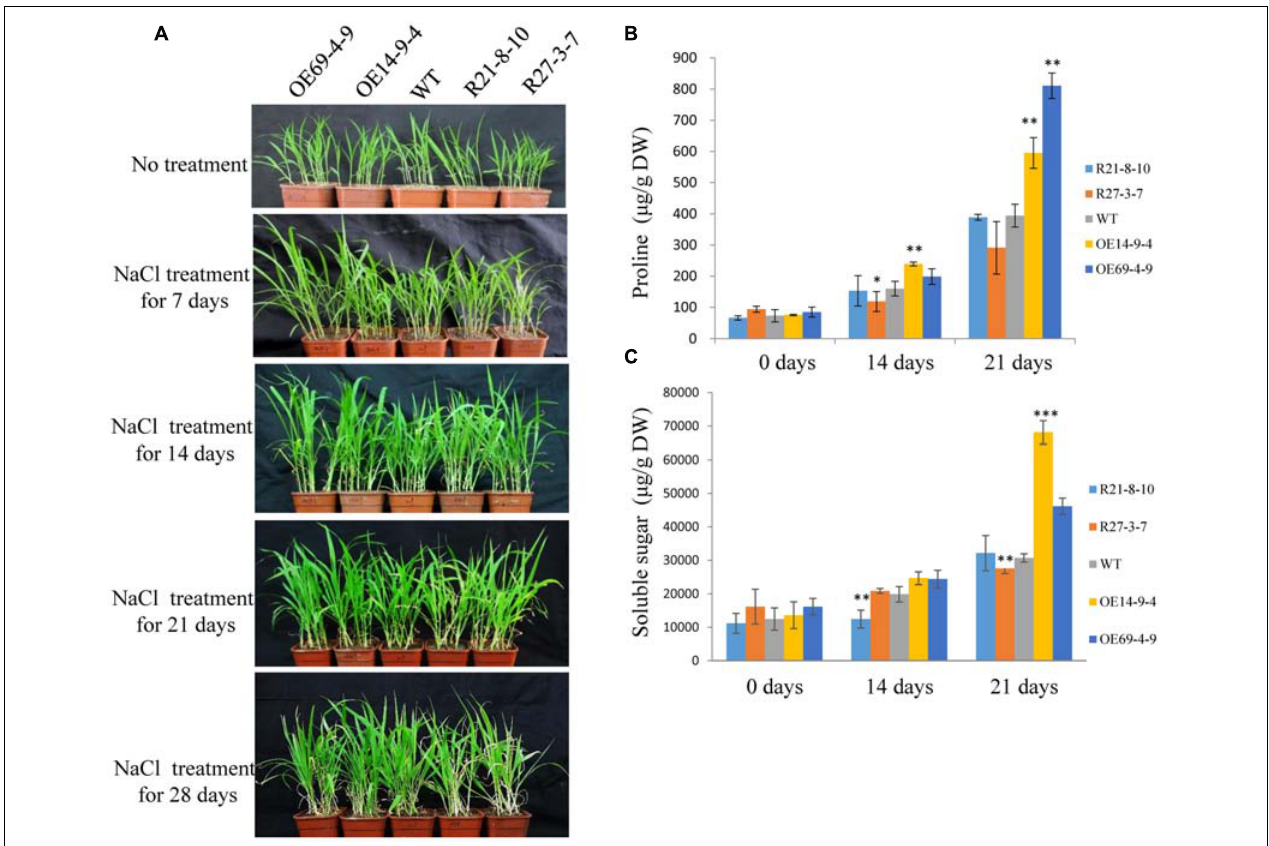
FIGURE 9 | Salt tolerance of SiLTP-OE and RNAi foxtail millet seedlings. The phenotypes of transgenic foxtail millet under a 100 mM NaCl treatment (A) . Proline contents (B) and soluble sugar contents (C) were analyzed in WT and transgenic plants after watering for 14 and 21 days with NaCl, respectively. ∗ , ∗∗ , and ∗∗∗ indicate statistically significant differences at P < 0.05, P < 0.01, and P < 0.001 (Student’s t -test),